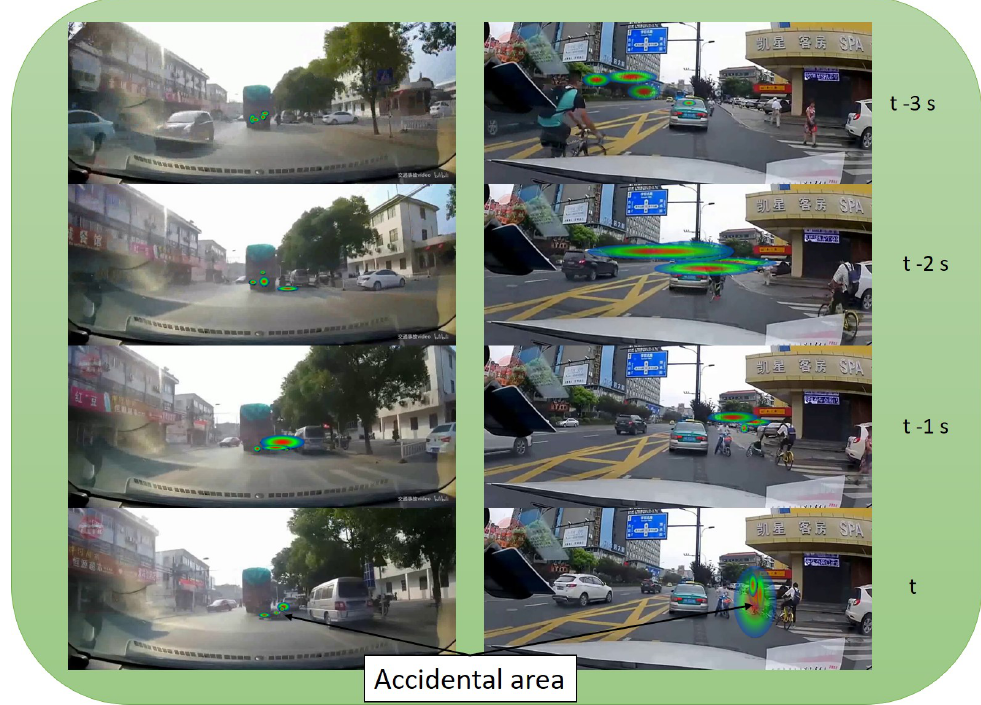
Figure 8. Attention map with temporal aggregation for the frame t, t − 1 s, t − 2 s and t − 3 s using NARMAX calibration